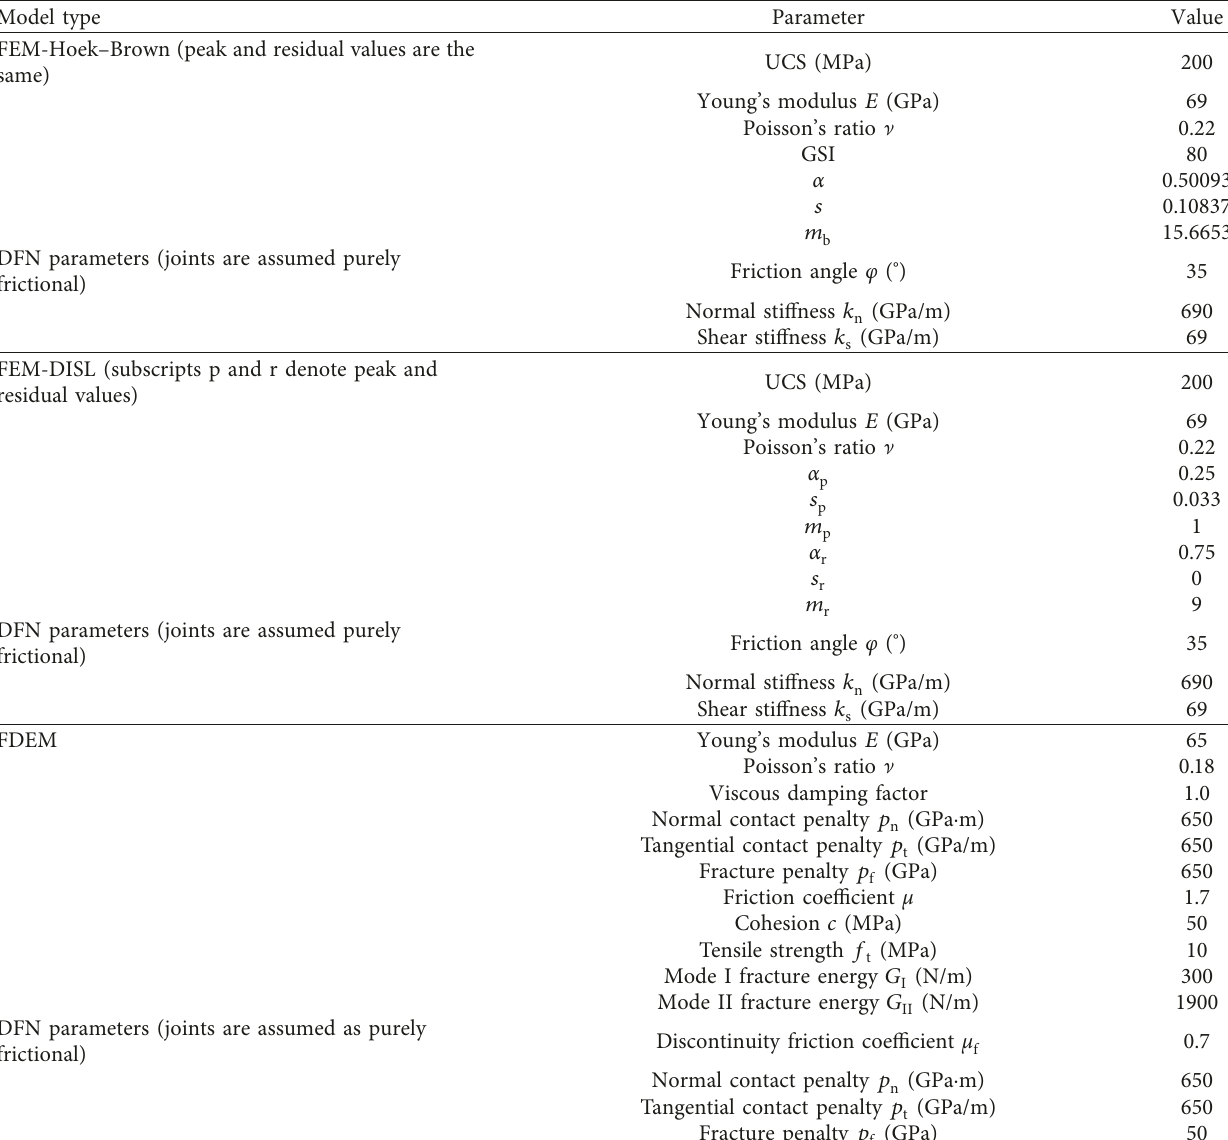
Table 5: Input material parameters for all numerical